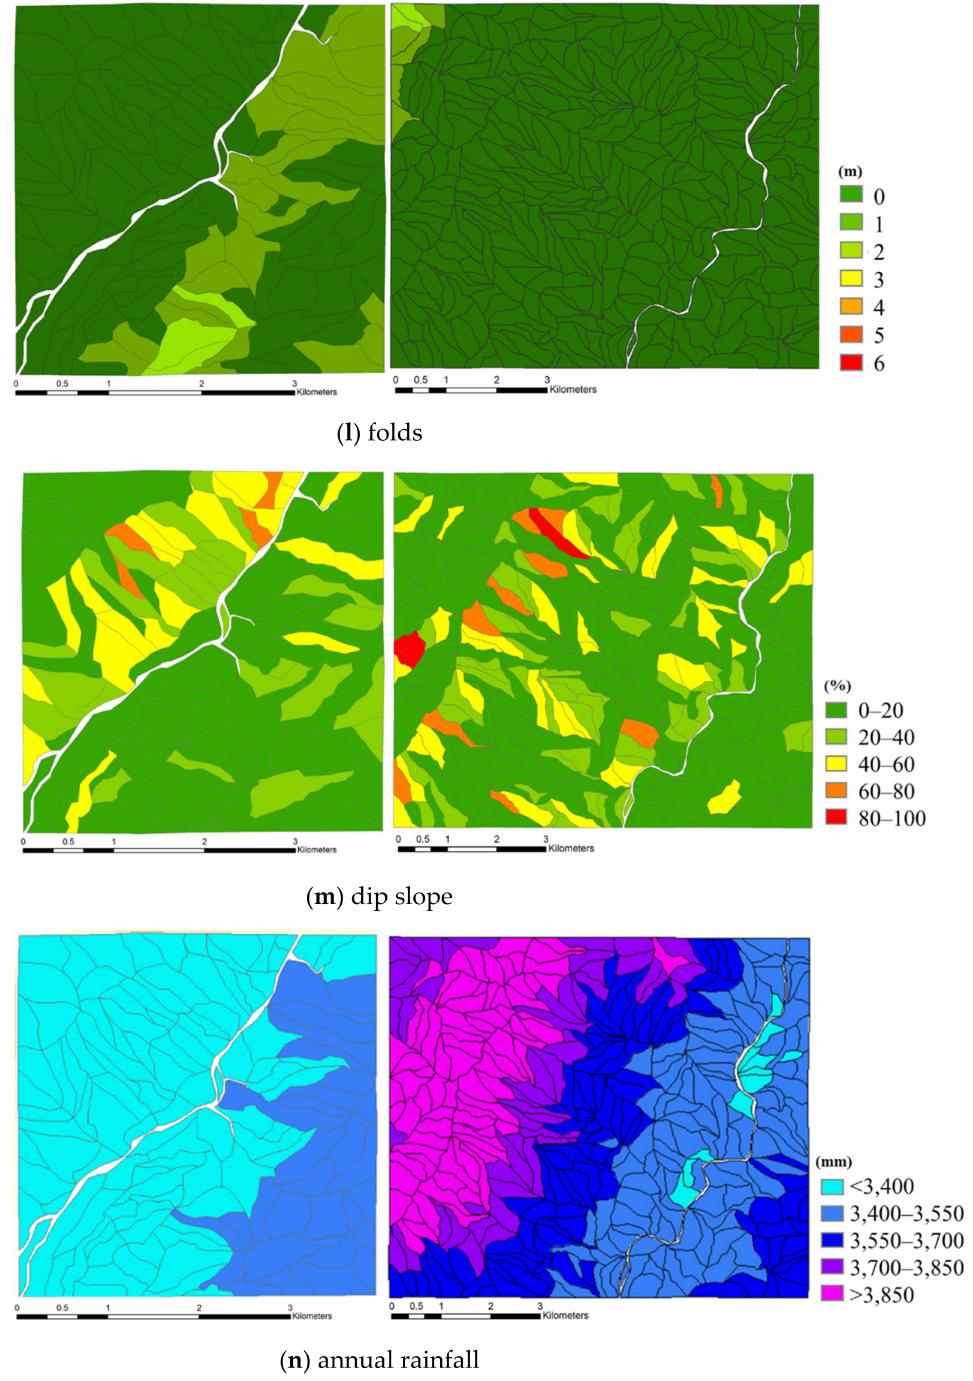
Figure 4. Fourteen spatial factors used in this study. These observations in 2017 are for Siaolin Village ( left ) and Putunpunas River ( right